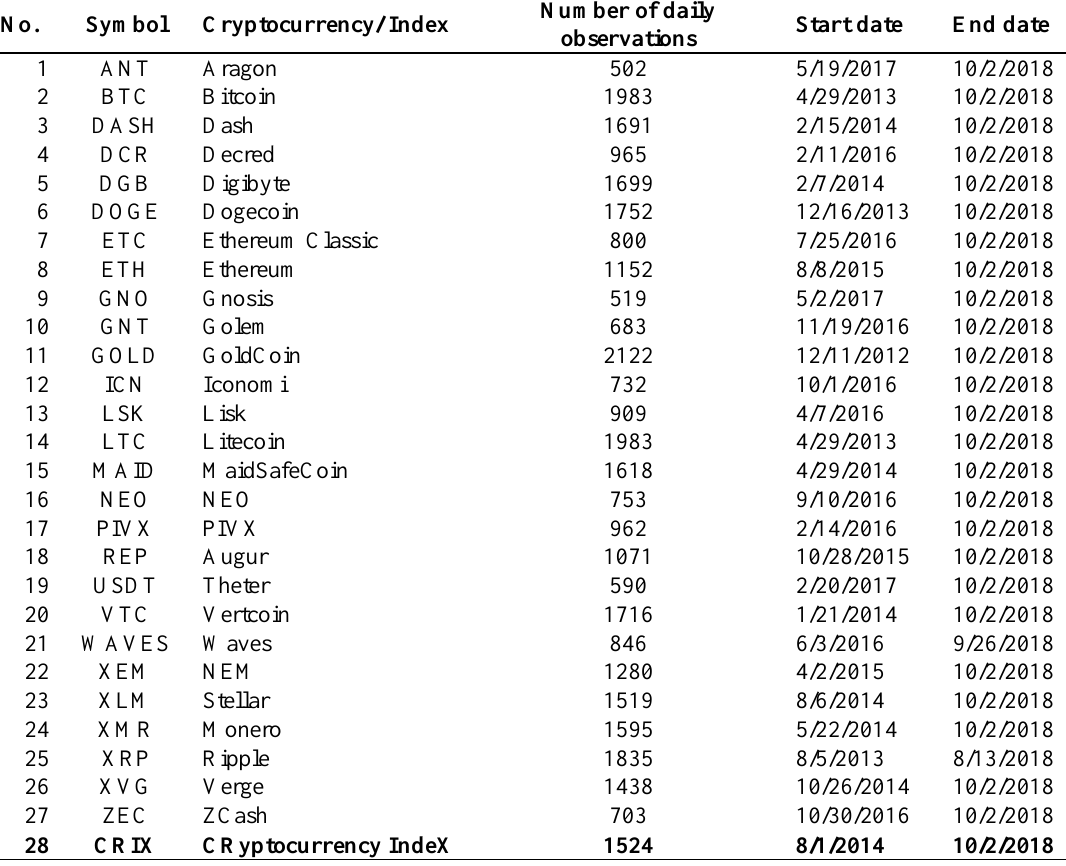
Table 1 : Description of the